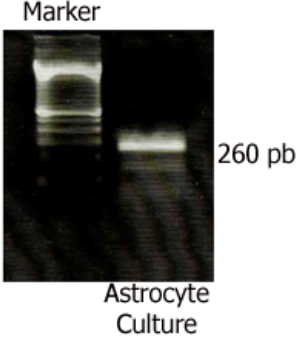
FIGURE 7 - Agarosis gel showing RNA expression of glial fibrillary acid protein (GFAP) in an astrocyte cell culture from mouse spinal cord. Sample was obtained